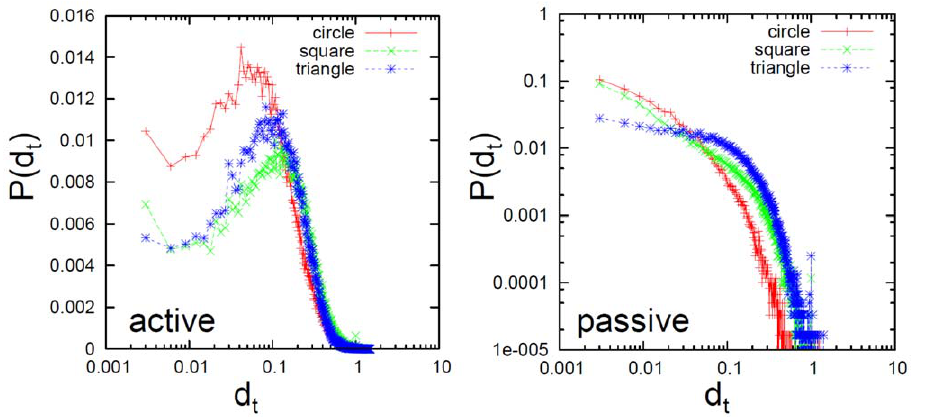
Figure 6. Comparisons of the probability distributions ( P ( d t ) ) as a function of d t . Note that the plots of the active elements (left) are semi- log plots, while the plots of the passive elements (right) are log-log plots. For each plot of the probability distribution, we discretized the range (0, 1.5) into 500 bins and calculated the probability distribution, and then averaged over all trials. Note that, in the passive elements, the tails of the distributions for the square and the triangular cases seem to follow the power law. For the square case, the slope was 2 0.888 in the region of (0.003, 0.21), while for the triangular case, it was 2 0.345 in the region of (0.003, 0.09). The slopes were fitted by using the least-squares method.